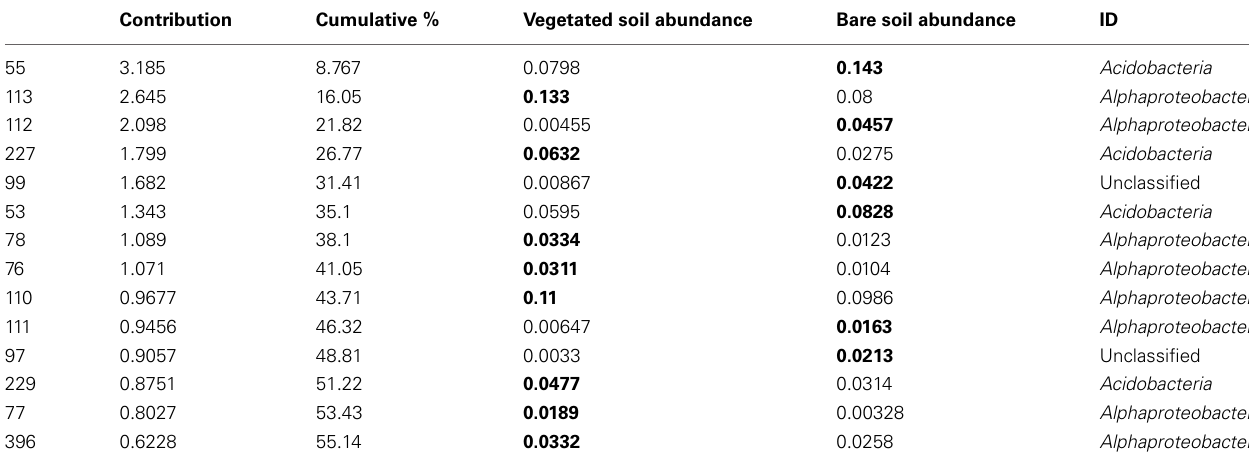
Table 2 | Analysis of dominant bacterial taxa in vegetated and bare